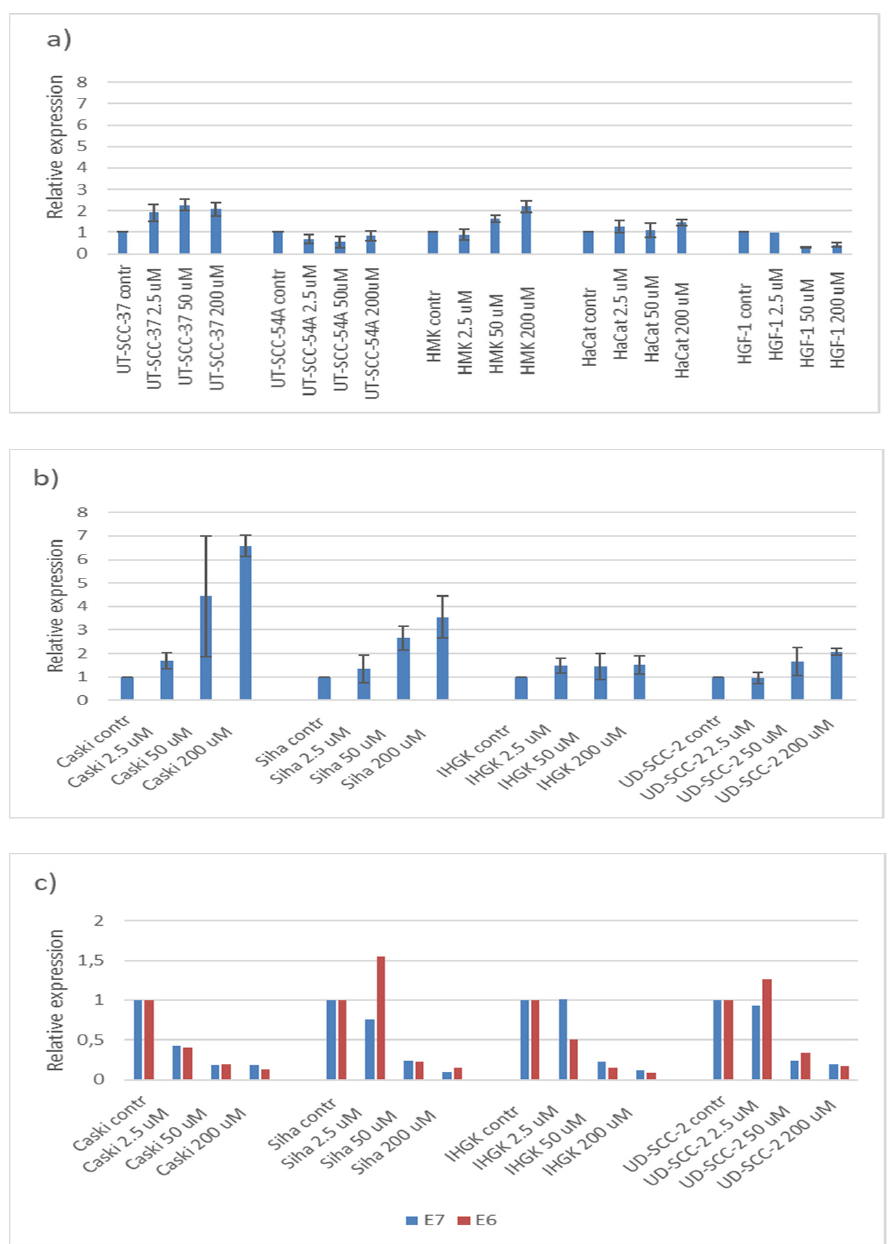
Figure 4. Relative gene expression of p21 and HPV16E6 and HPV16E7. The cells were exposed to different hinokitiol concentrations (0, 2.5, 50, and 200 μ M) for 24 h and the p21 expression in ( a ) HPV16 negative and ( b ) HPV16 positive cell lines and ( c ) HPV16 E6, and HPV16E7 expressions were measured by qPCR. The relative expression of target genes HPV16 E6, HPV16 E7, and p21 were normalized using GAPDH as a reference gene.